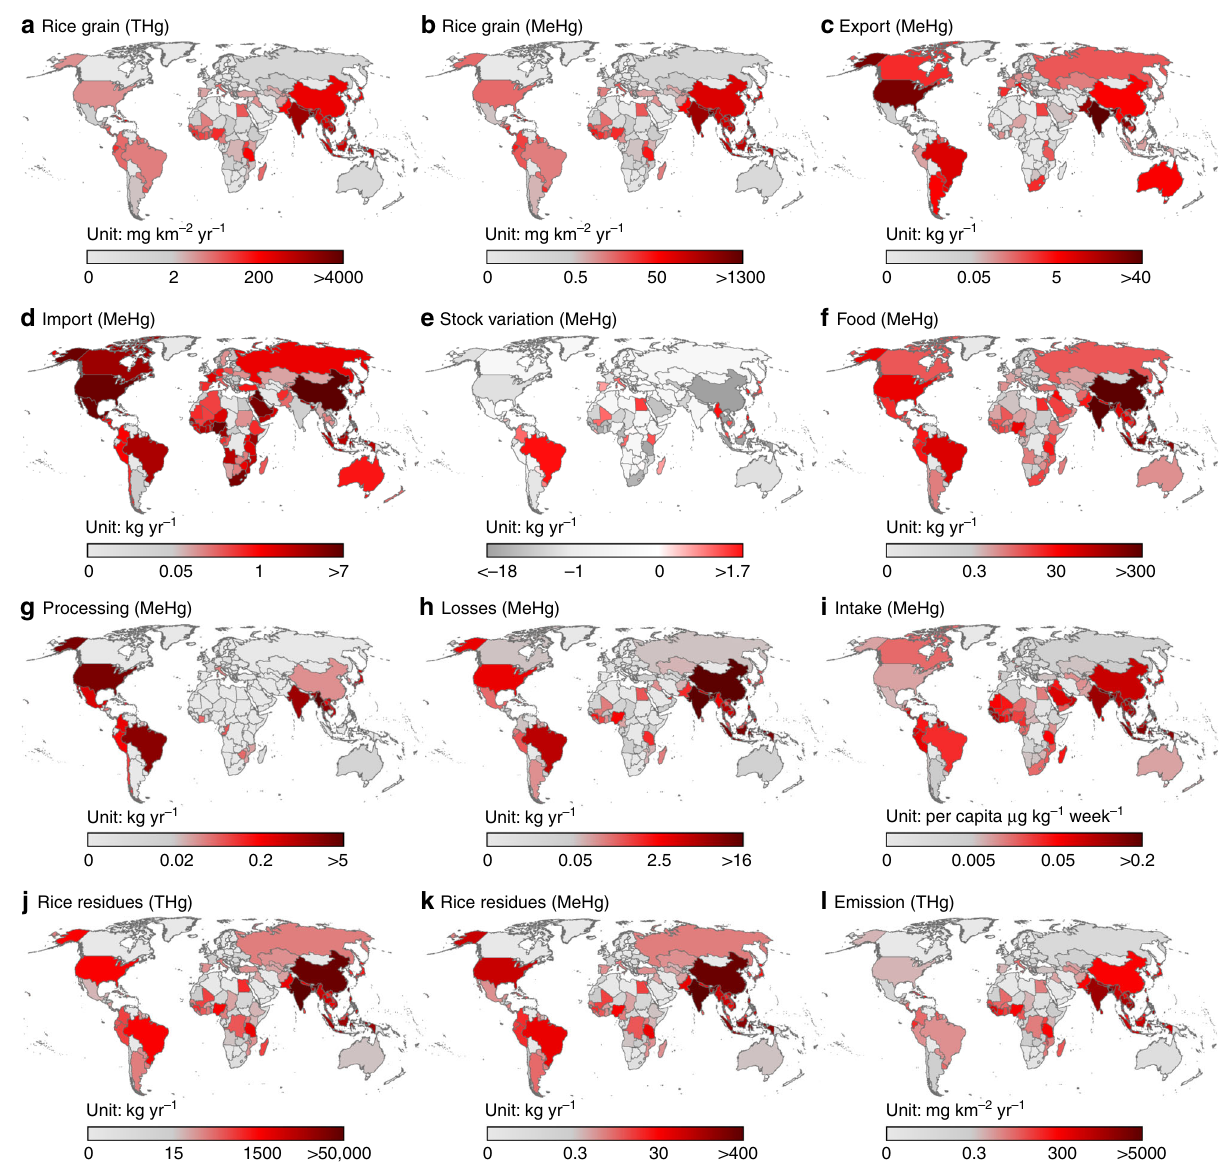
Fig. 1 Global distribution of mercury generated during the rice life cycle. a , b Amounts of THg and MeHg generated in rice grain in 2016; c , d amounts of MeHg transported by rice export and import in 2016, respectively; e stock variation of MeHg in 2016; f amounts of MeHg supplied as food in 2013; g amounts of MeHg related to processing in 2013; h amounts of MeHg losses during transportation in 2013; i per capita probable weekly intake (PWI) of MeHg in 2013; j , k THg and MeHg sequestered in rice residues in 2016; l THg emitted from rice residue burning in fi elds in